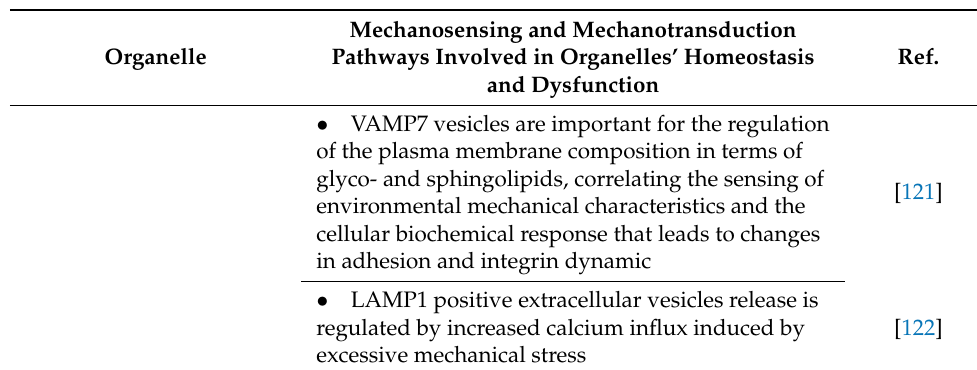
regulated by increased calcium influx induced by excessive mechanical